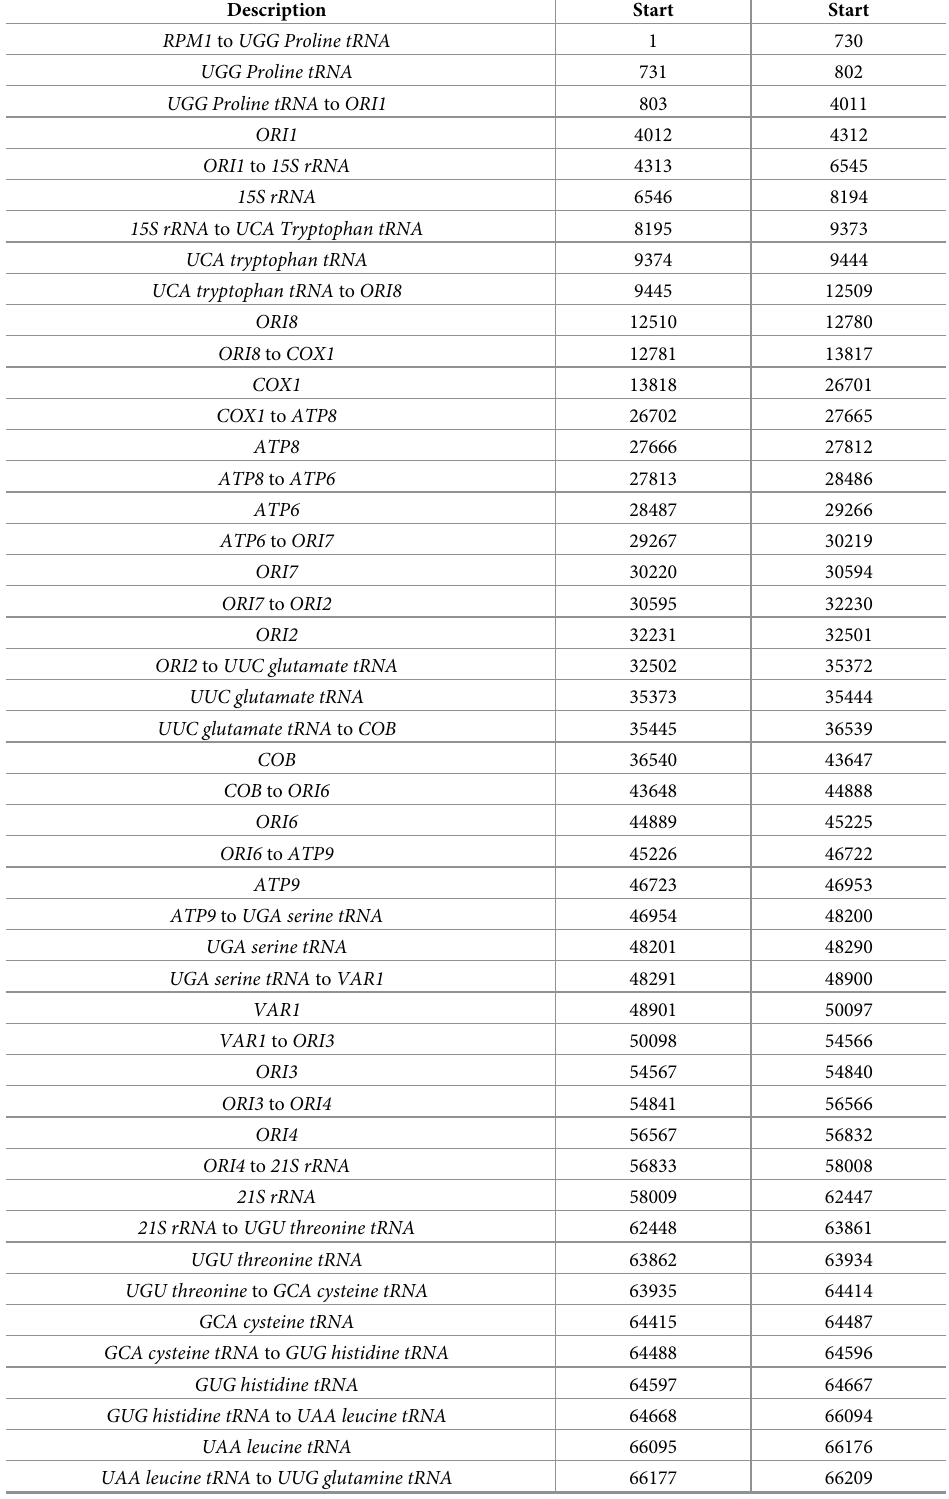
Table 4. Bin Boundaries for pet127-nd RNA